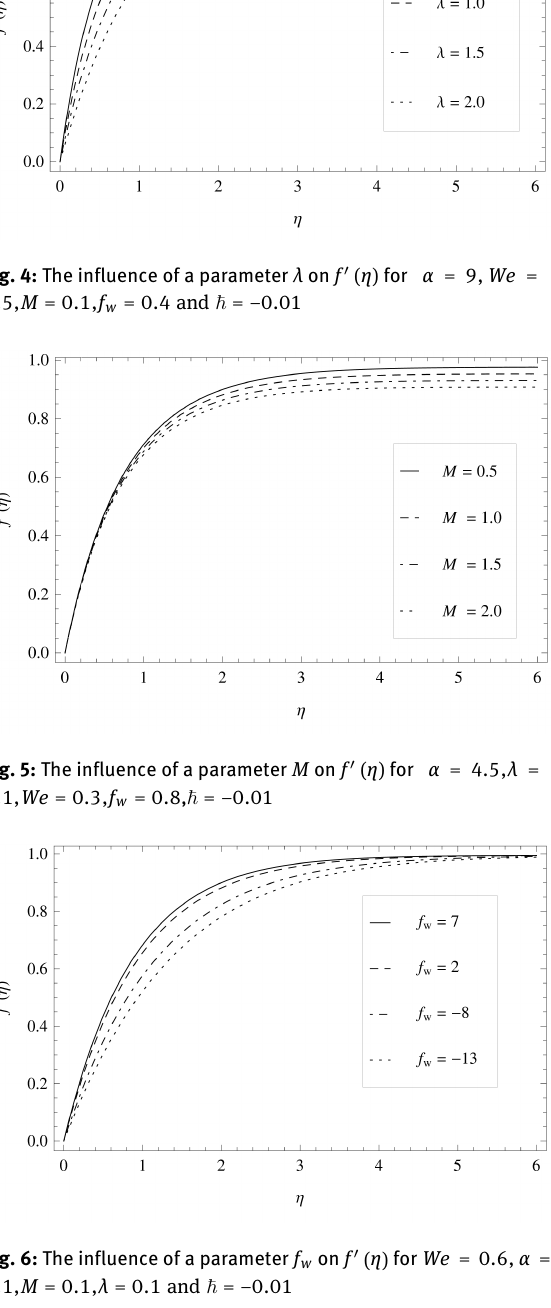
Fig. 3: The influence of a parameter We on f (cid:48) ( η ) for α = 2, λ = 0.5, M = 1, f = 0.7 and (cid:126) = −0.01 w